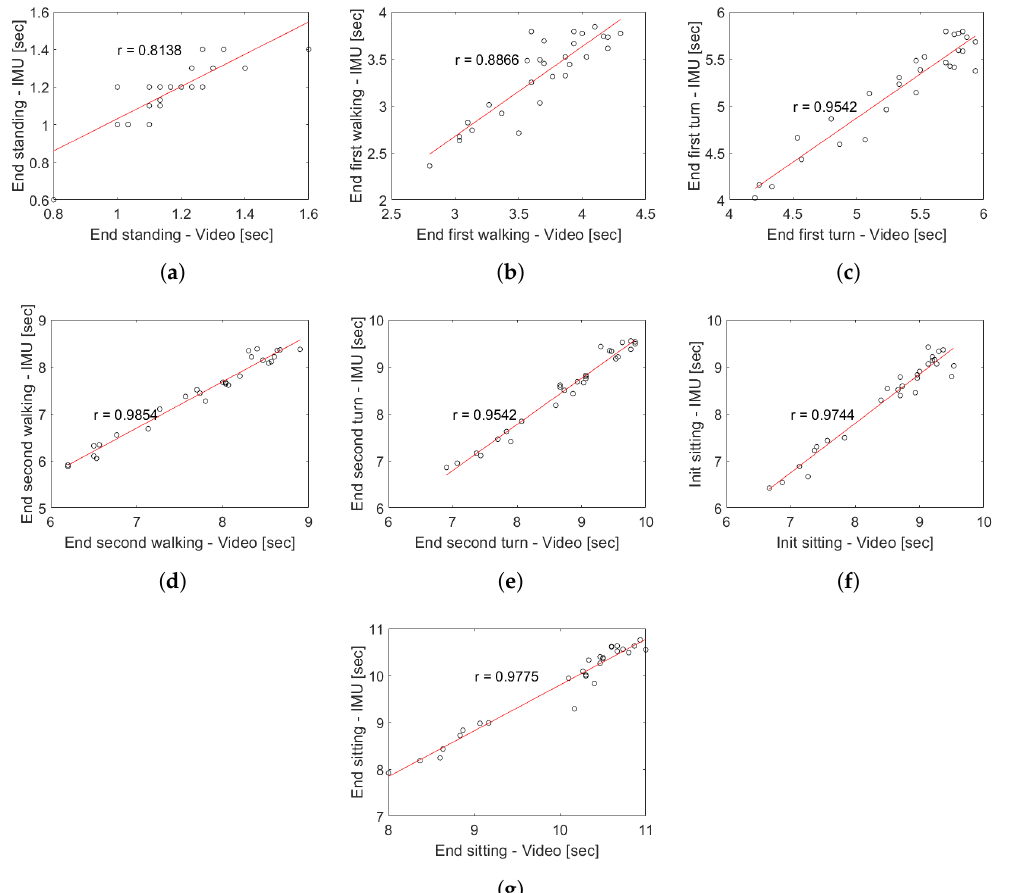
Figure 14. Pearson correlation coefficient for the segmentation time for each sub task of the TU & Go test in young subjects. ( a ) end of the standing/start of the first walk; ( b ) end of the first walk/start of the 3-m turn; ( c ) end of the 3-m turn/start of the second walk; ( d ) end of the second walk/start of the pre-sitting turn; ( e ) end of the pre-sitting turn; ( f ) start of the sitting; ( g ) end of the